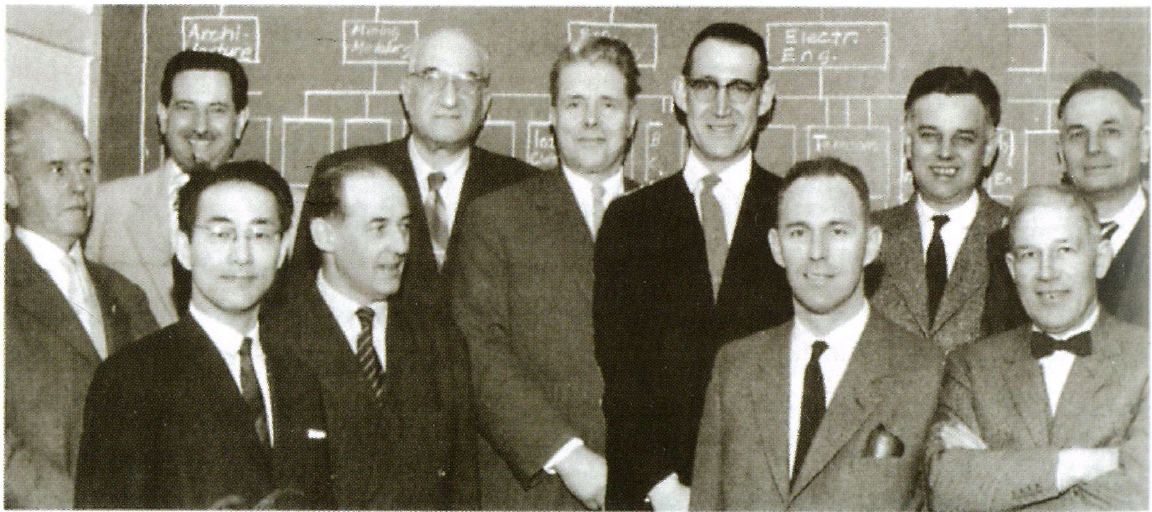
Figure 4: The IFAC Executive Council is gathered in Norway in 1961. Young Jens is located in the first row, second from the right. To his left stands Harold Chestnut, the first president of IFAC. dustrializing the ideas coming out of his